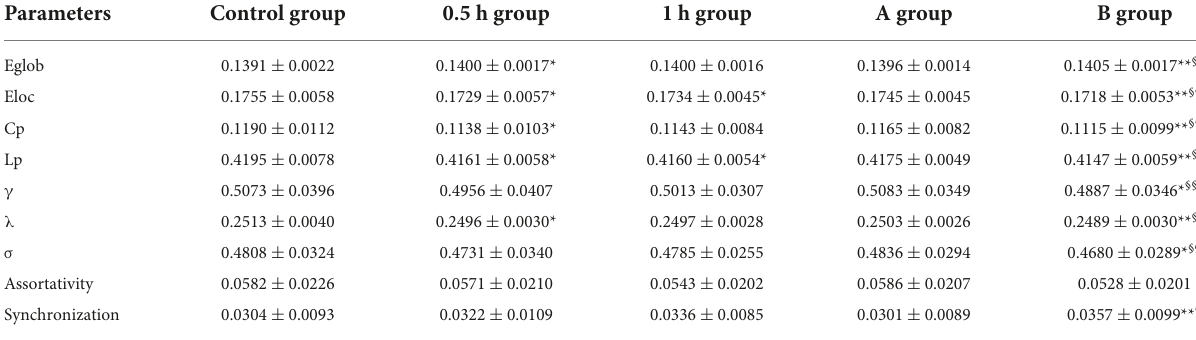
TABLE 2 Global network parameters in each